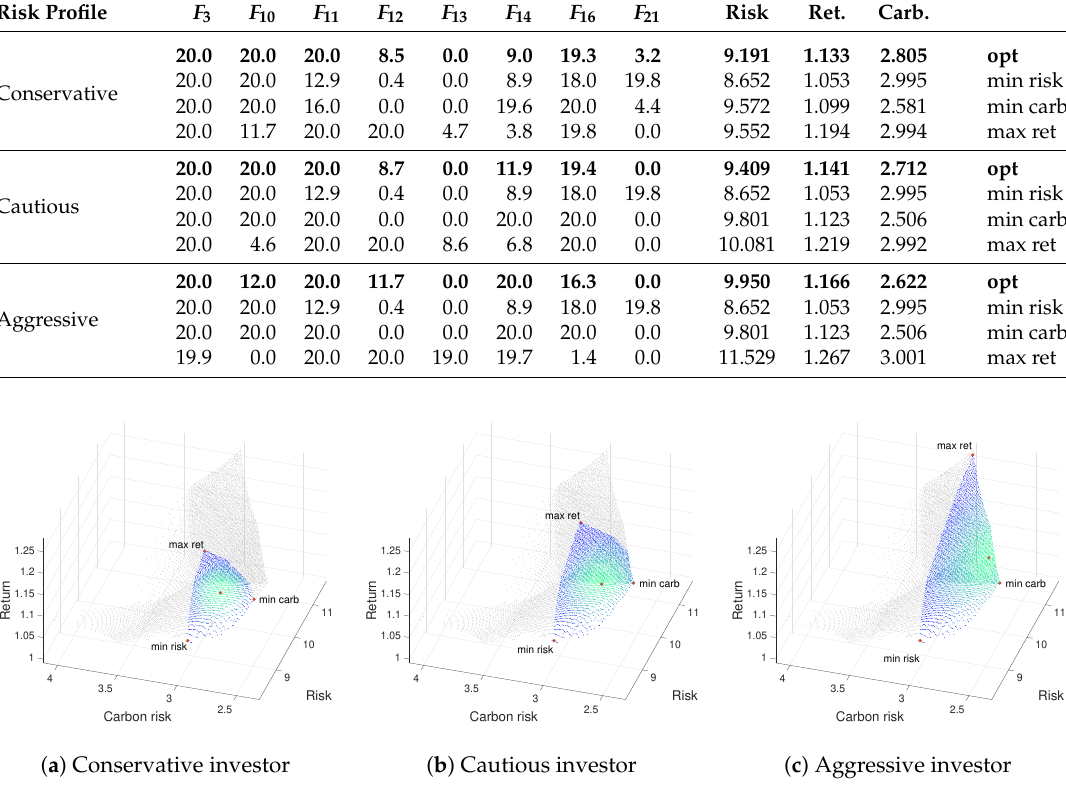
Figure 3. 3D Pareto fronts for a Moderate green investor profile. ( p m g ): on the left, for the Conservative profile ( p c r ); on the center for the Cautious investor ( p k r ); and on the right for the Aggressive profile ( p a r ). Table 4. Strong green investor portfolio composition and objective value